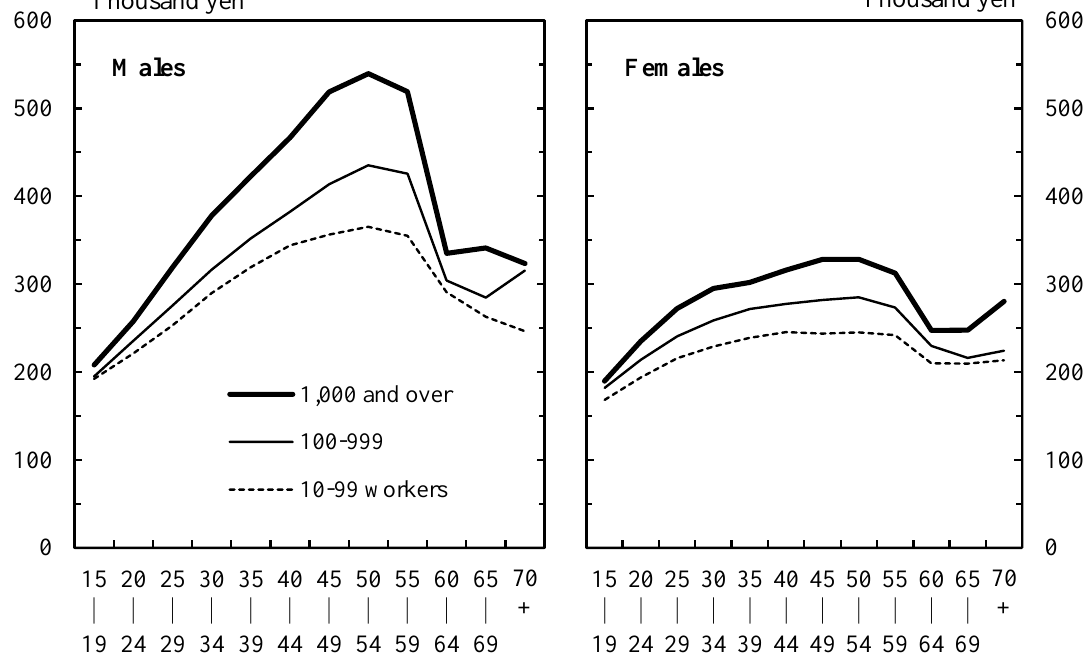
Monthly Contractual Cash Earnings by Size of Enterprise